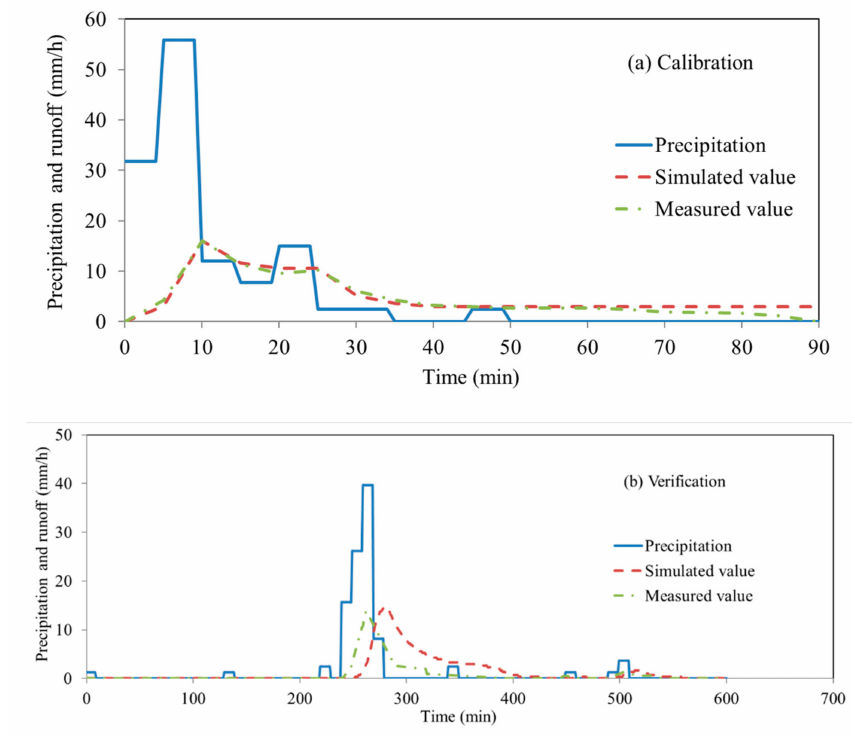
Figure 2. Simulated and measured values of green roof runo ff during model ( a ) calibration and ( b )